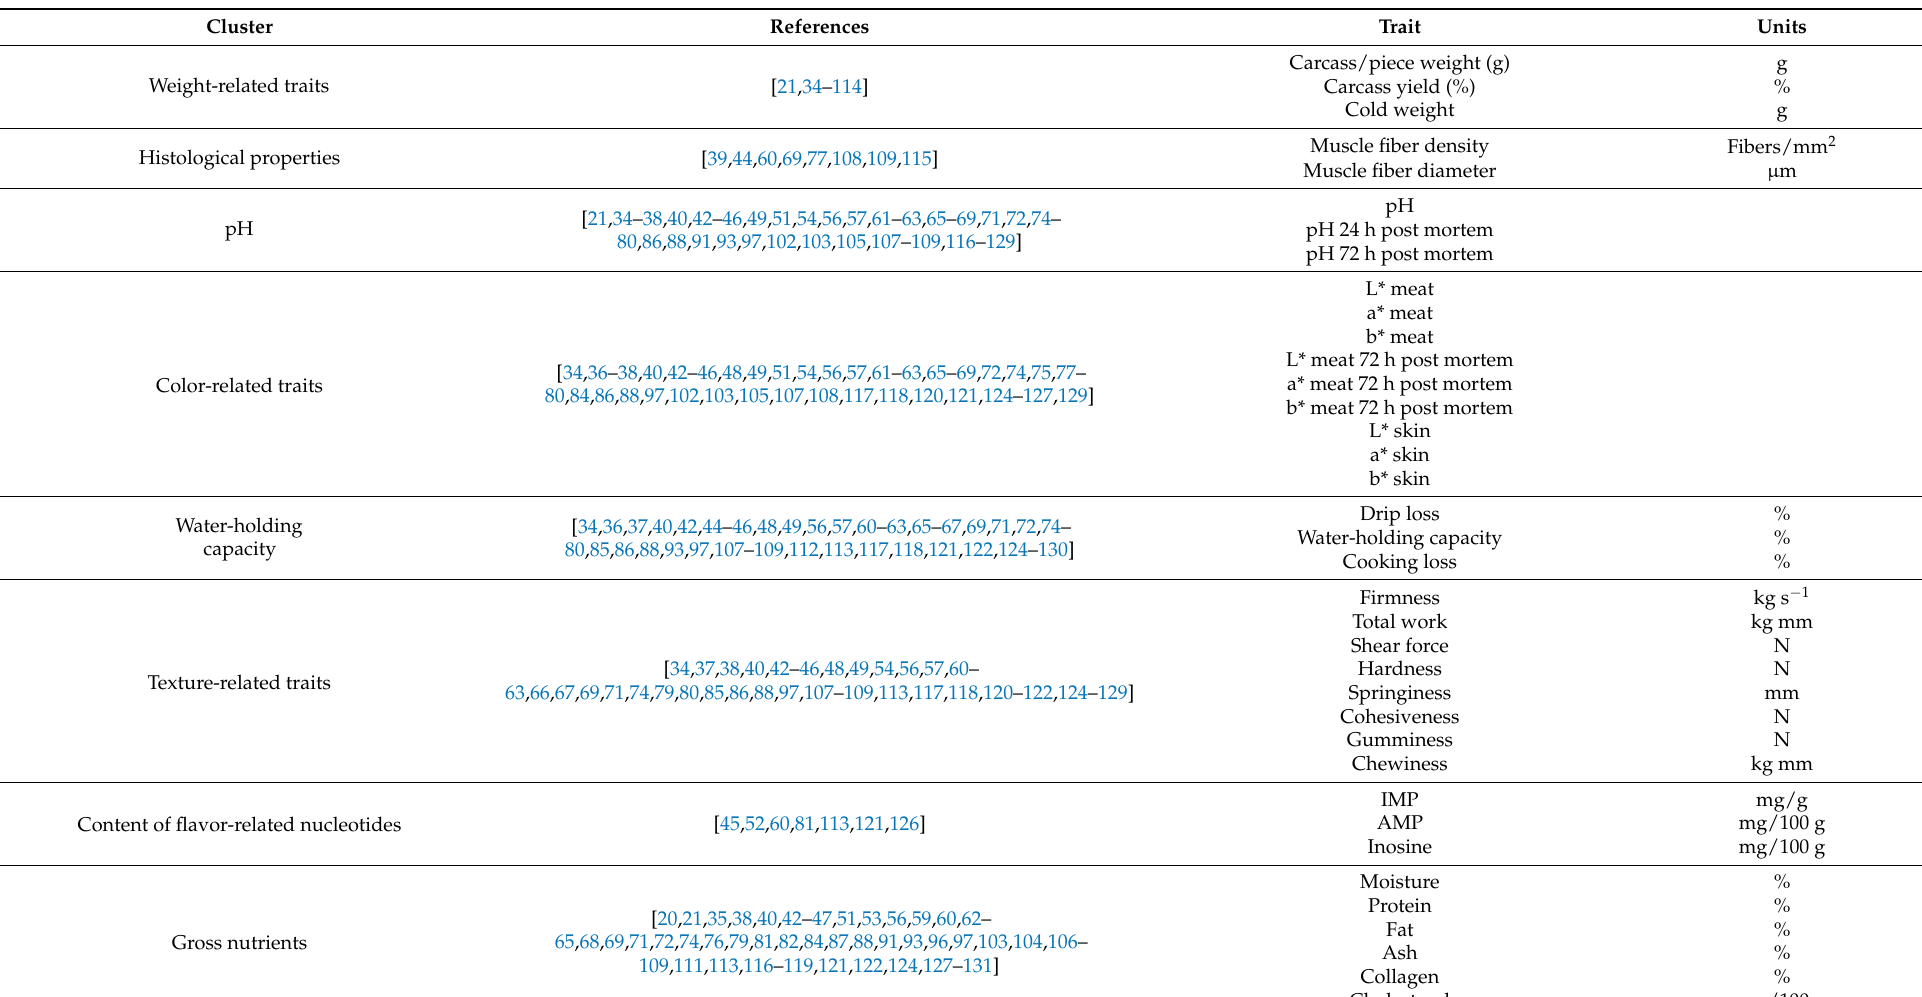
Table 1. Clusters, references, and units of the traits considered in the